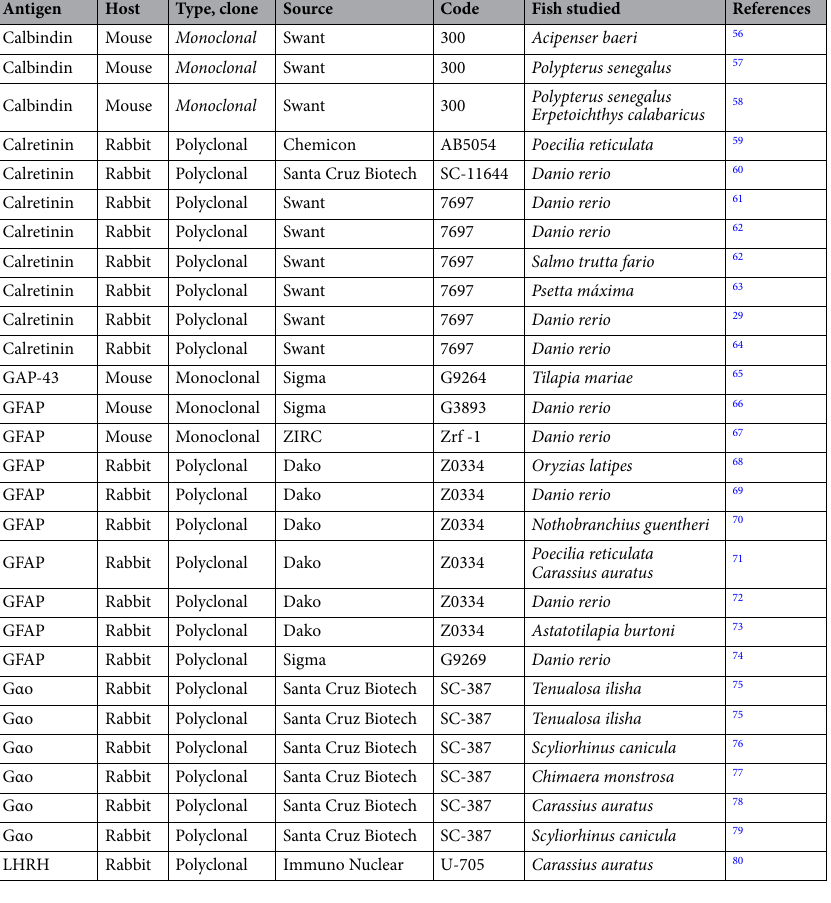
Table 2. Previously published use in fishes olfactory system studies of the antibodies employed in this study against the same